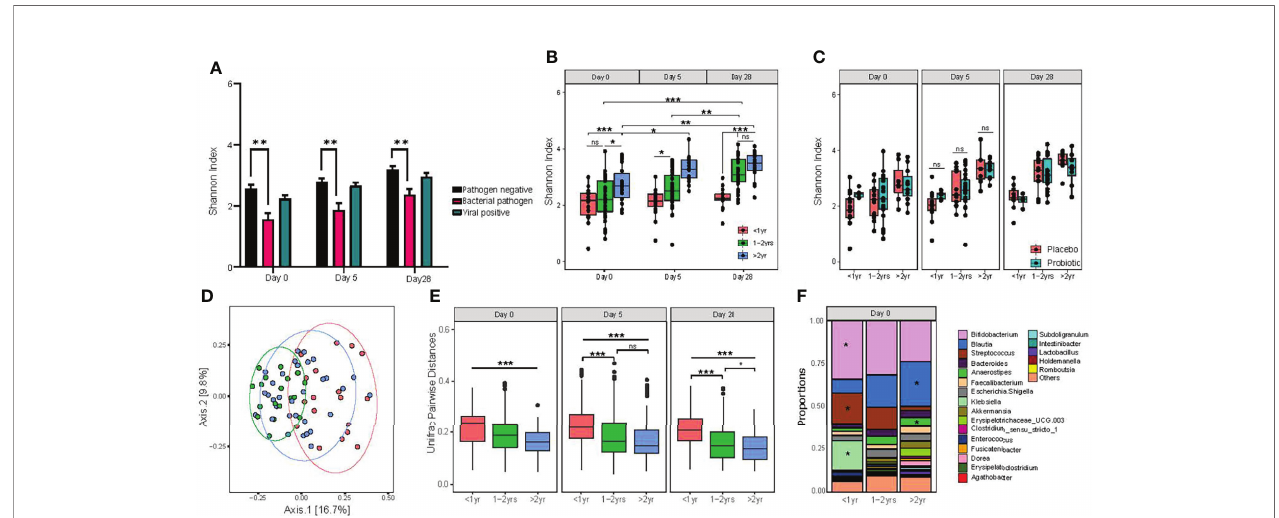
FIGURE 3 | Detection of bacterial enteric pathogens and participant age both impact on the diversity of gut microbiota composition. (A) differences in alpha diversity associated with pathogen carriage status; (B) alpha diversity of age categories, as measured by the Shannon diversity index; (C) alpha diversity, measured by Shannon index, between probiotic and placebo treat groups within age categories. Statistical signi fi cance was assessed by two-way ANOVA, with Tukey ’ s multiple comparison testing; (D) principal coordinate analysis of unweighted Unifrac distances. Signi fi cance was assessed by using PERMANOVA; (E) pairwise dissimilarity distance comparison between age categories on study day 0, day 5 and day 28 using unweighted Unifrac distances. One-way ANOVA followed by Tukey ’ s multiple comparison testing; and (F) relative abundance of the top 20 genus level taxa, with statistically signi fi cant differences between age groups for Bi fi dobacterium , Blautia , Streptococcus , Anaereostipes and Klebsiella . Signi fi cance denoted by *P < 0.05, **P < 0.01 and ***P < 0.001. NS indicates no statistical signi fi